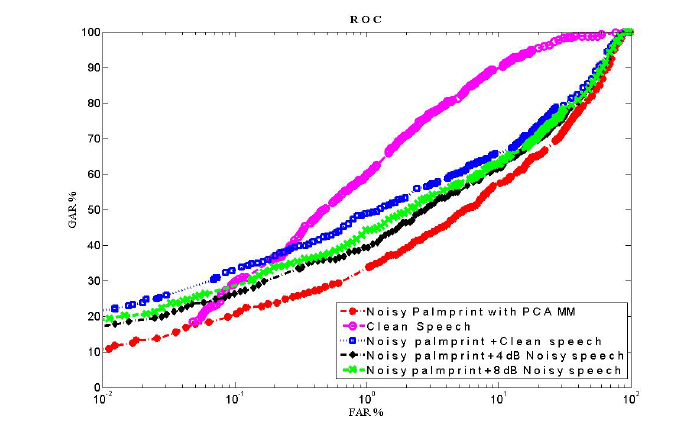
Figure 12. ROC curves for match score level fusion of noisy palmprint using PCA MM with speech (both clean and noisy).